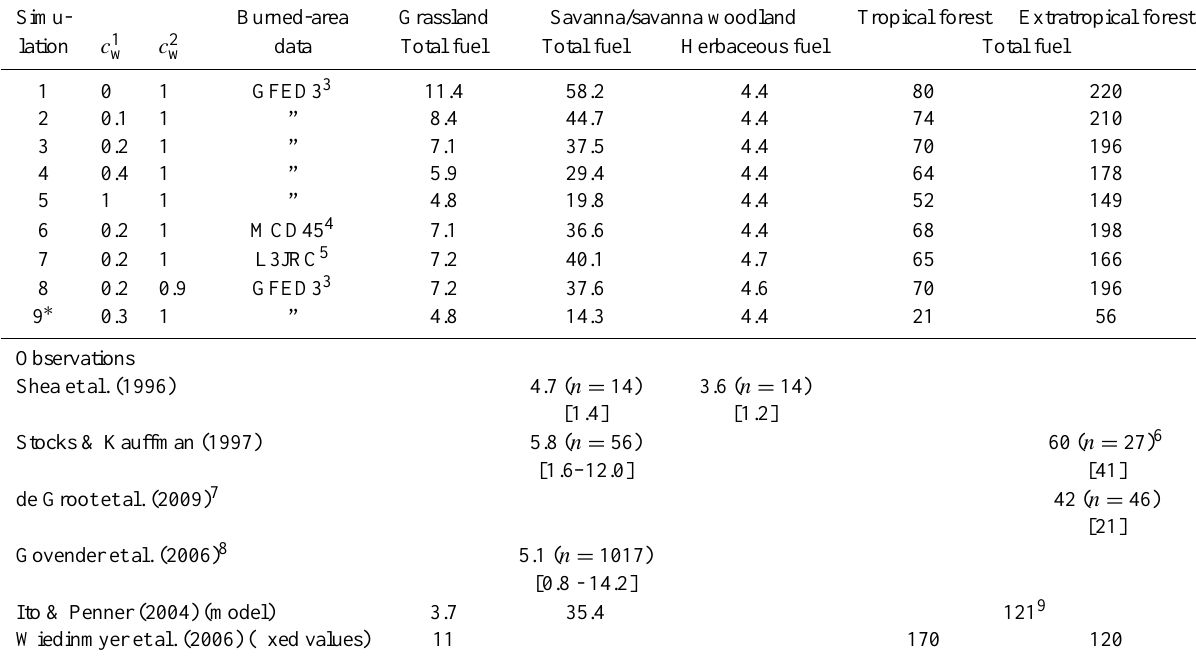
Table 2. Simulations with LPJ-GUESS, simulated and observed fuel loads in t dry matter/ha. Simu- Burned-area Grassland Savanna/savanna